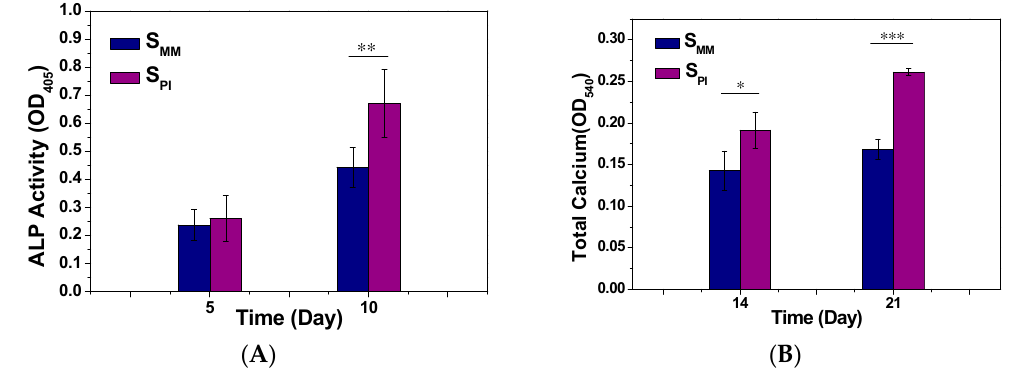
Figure 7. ALP activity ( A ) and Ca deposition ( B ) of S MM and S PI . Data are presented as mean ± SD ( n = 6, * p < 0.05; ** p < 0.01; *** p < 0.001).